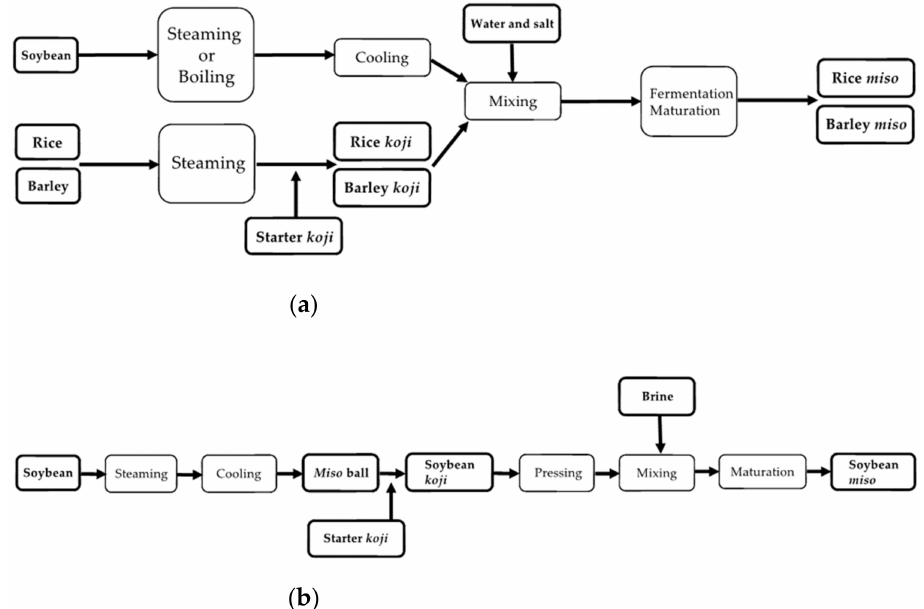
Figure 1. Overview of the miso making process for ( a ) rice and barley miso and ( b ) soybean miso